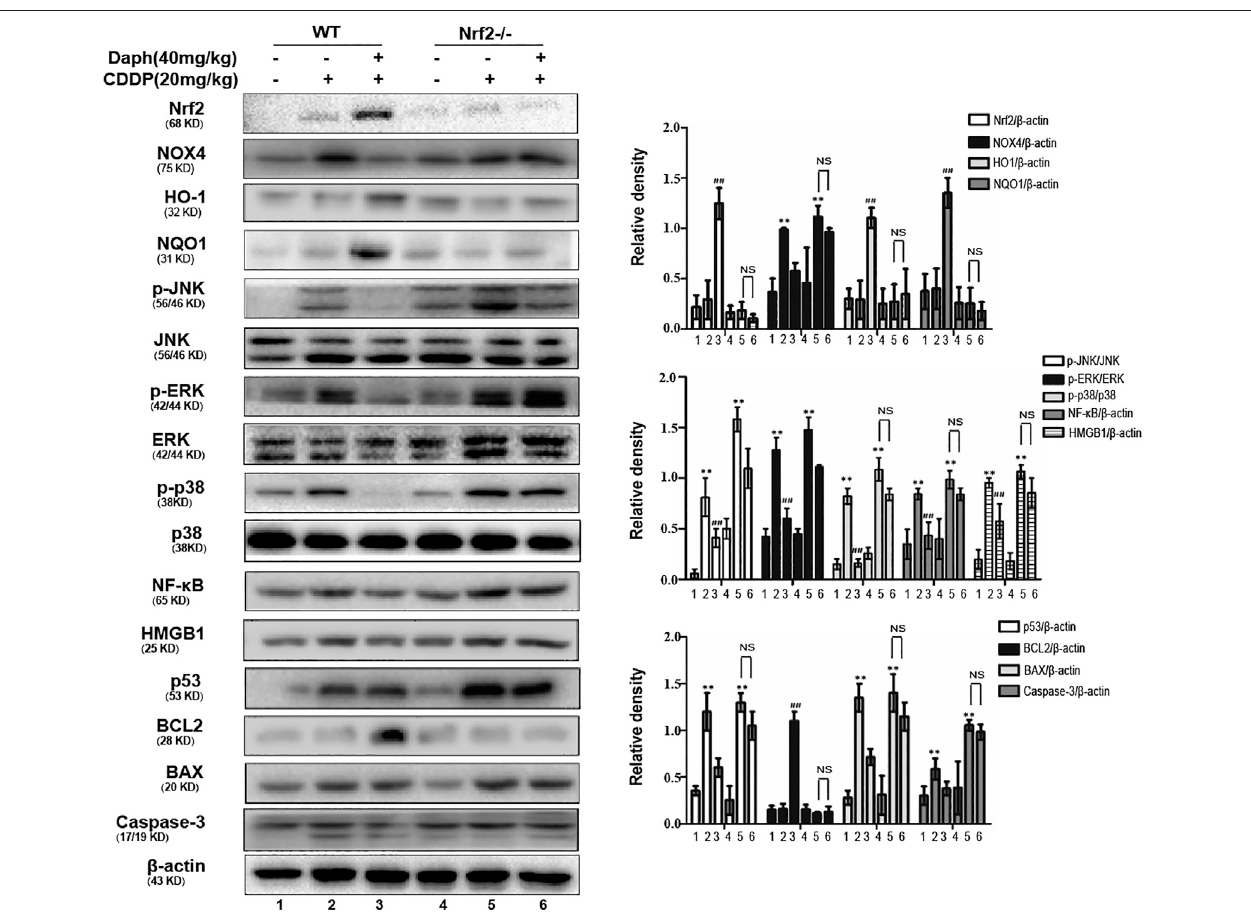
FIGURE 6 | Nrf2 is regulated by Daph relieved CDDP-induced AKI in mice. Mice were treated with Daph (40 mg/kg) or NAC (50 mg/kg) once a day for three consecutive days. CDDP (20 mg/kg) was administered once at 1 h after the fi rst Daph or NAC injection. Mice were sacri fi ced at 72 h after the CDDP administration. Westernblotsanalysisshowingtheexpression levelsofproteininthekidneys fromofWT andNrf2 − / − mice.* p < 0.05and ** p < 0.01vs. theCDDPgroup; ## p < 0.01vs. the control group; NS, not signi fi